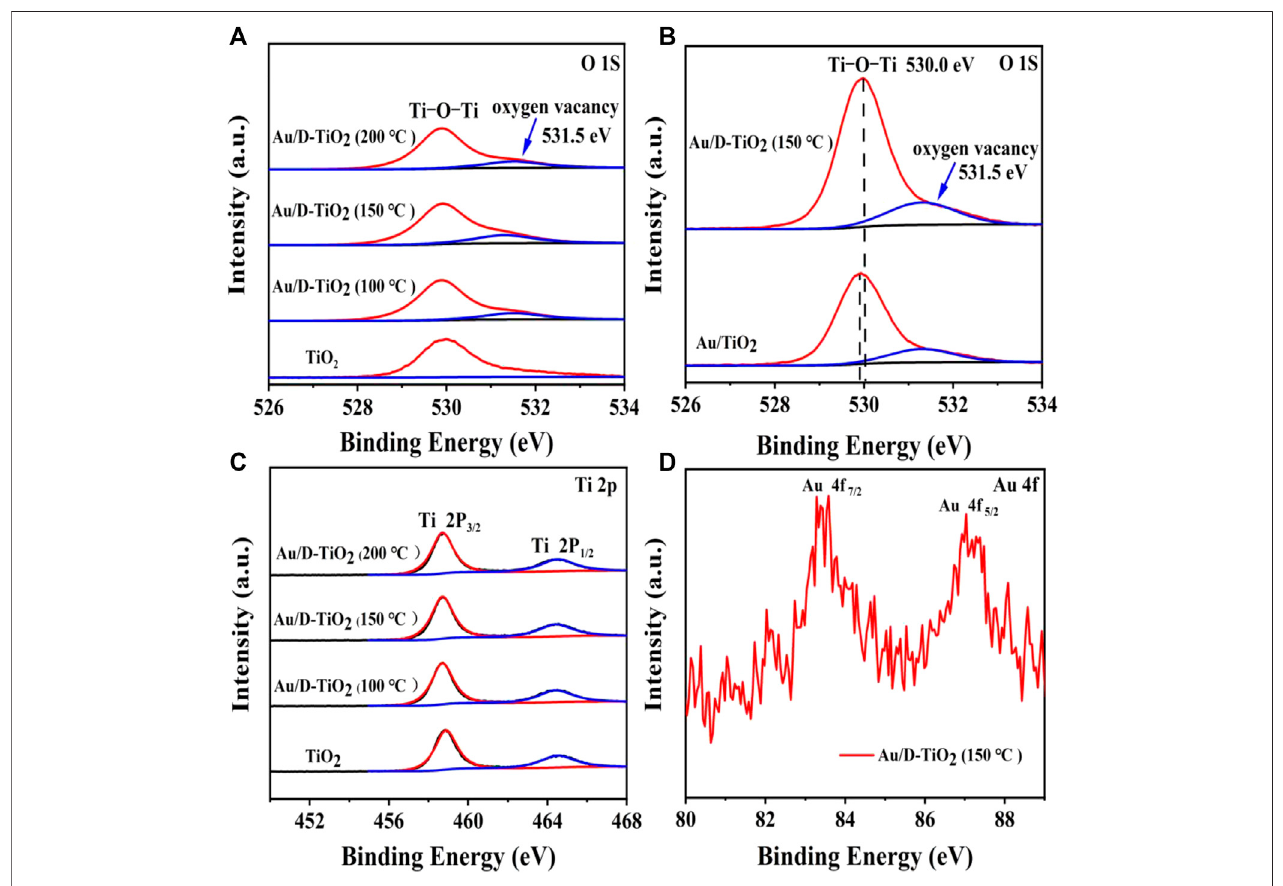
FIGURE3|(A) XPSofTiO 2 andD-TiO 2 (TheD-TiO 2 weretreatedat100 ° ,150 ° ,and200 ° C,respectively) (B) XPSofsynthesizedAu/TiO 2 andAu/D-TiO 2 (treatedat 150 ° C) (C) Ti 2p spectrum (D) Au 4f spectrum.